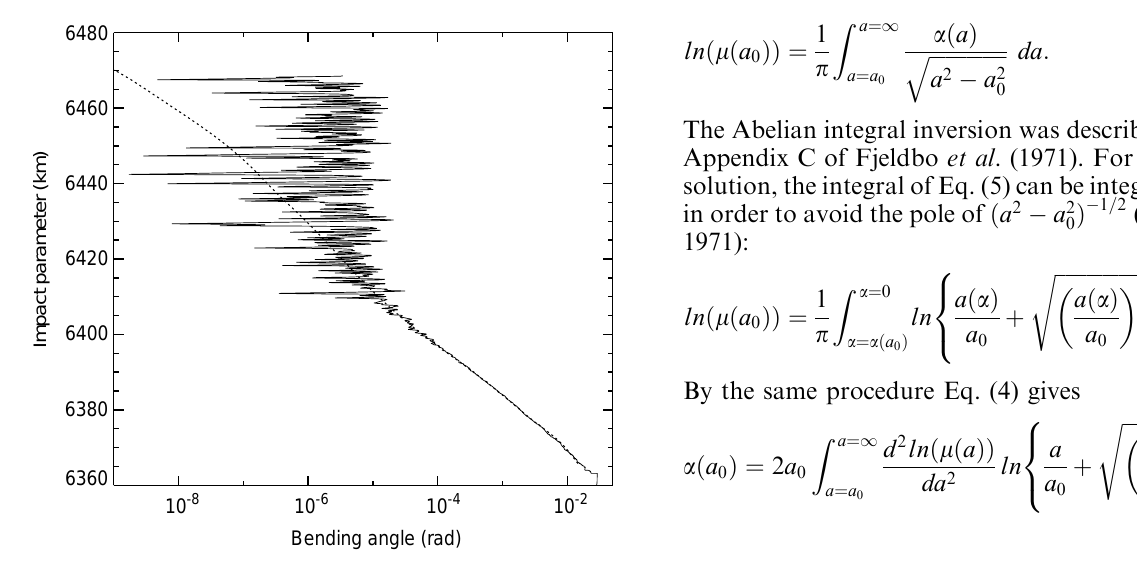
Fig. 3. Bending angle of the neutral atmosphere as function of height for one occultation event. The solid line is the bending angle retrieved from the GPS/MET measurements (event 0030-04.27-95.182). The dotted line is calculated from the density profile of the MSISE-90 model at the place and time of